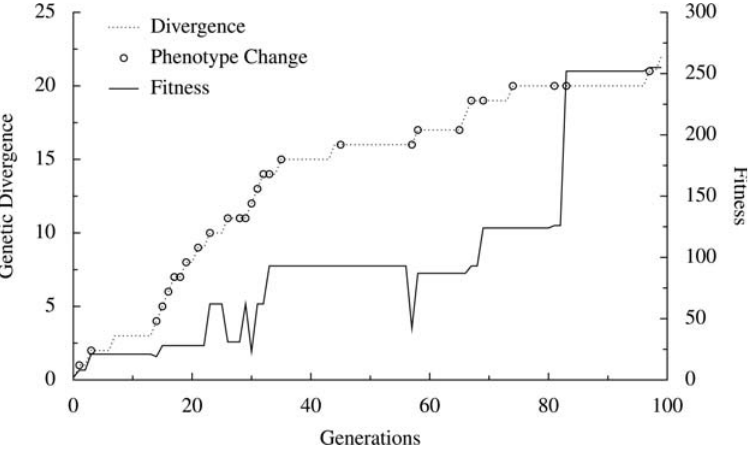
Figure 11. Genotype, phenotype, and fitness in a single evolving lineage. Shown are three network properties over 100 generations in the lineage leading to the network shown in Fig. 9A. Genotypic divergence (dotted line) is the number of letters x in the network sequence, either in regulatory or coding regions, different from the ancestor. Changes in phenotype (open circles) are points at which the attractors of the network change, whether or not this results in a change in length of the longest attractor. Fitness (solid line) is the length of the longest attractor in the network state space. Note that changes in either genotype or phenotype may be effectively neutral, without corresponding changes in fitness, and that large changes in fitness can occur with relatively small changes in